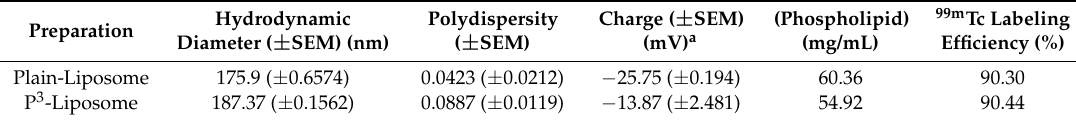
Table 1. Physicochemical properties of Plain- and P 3 -liposomes.